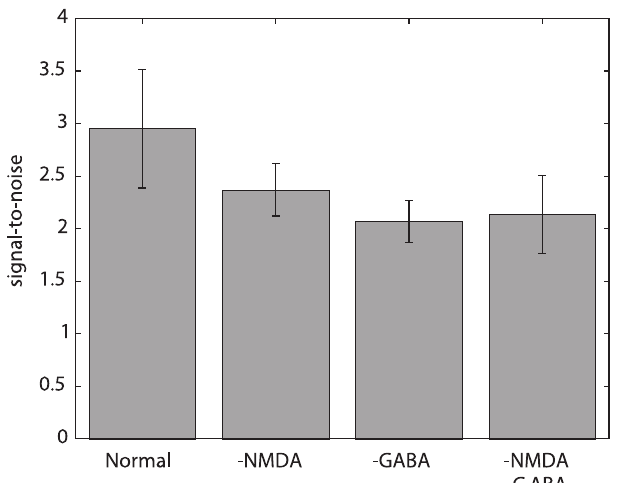
Figure 6. Signal-to-Noise Ratio of a Measure Related to the Blood Oxygenation Level–Dependent Signal We computed the mean and standard deviation of averages of the synaptic currents of the selective pool over the whole simulation period of a persistent condition simulation. The mean of the spontaneous baseline condition was subtracted. We conducted 1,000 simulated trials. The signal-to-noise ratio is calculated by division of the mean synaptic current by the standard deviation measured using 1,000 trials. The error bars indicate an estimate of the standard deviation measured over 20 epochs containing 50 trials each. A modulation of the synapses shown as (cid:2) NMDA and (cid:2) GABA corresponds to a reduction of 4.5% and 9% in their conductances, respectively.